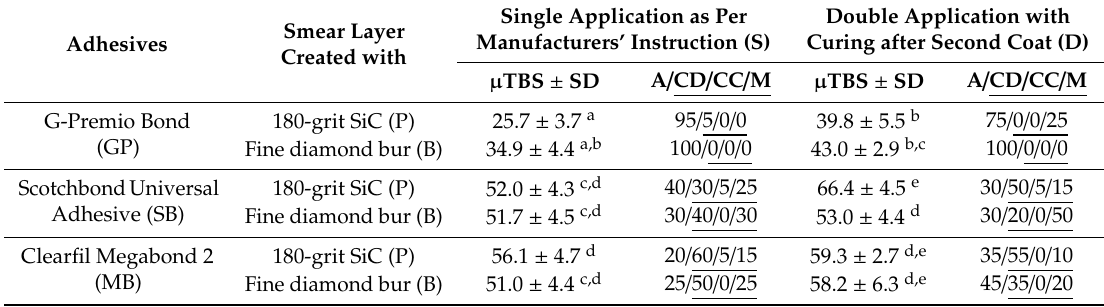
Table 1. Mean µ TBS (MPa) ± standard deviations (SD) and percentage of fracture modes (A / CD / CC / M)